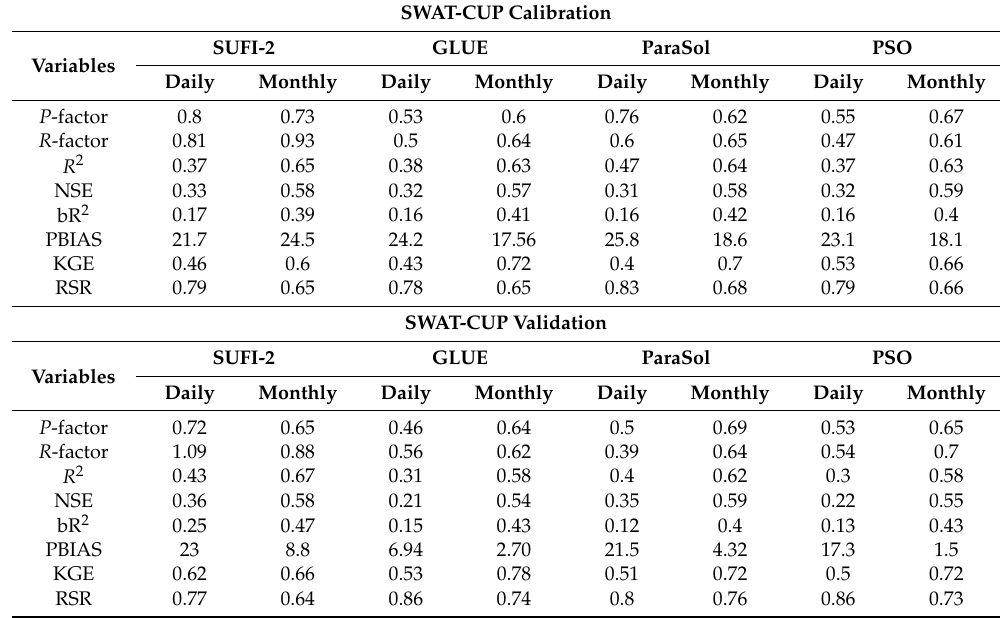
Table 4. Daily and monthly streamflow calibration (1992–2001) and validation (2002–2007) statistics using SUFI-2, GLUE, ParaSol, and